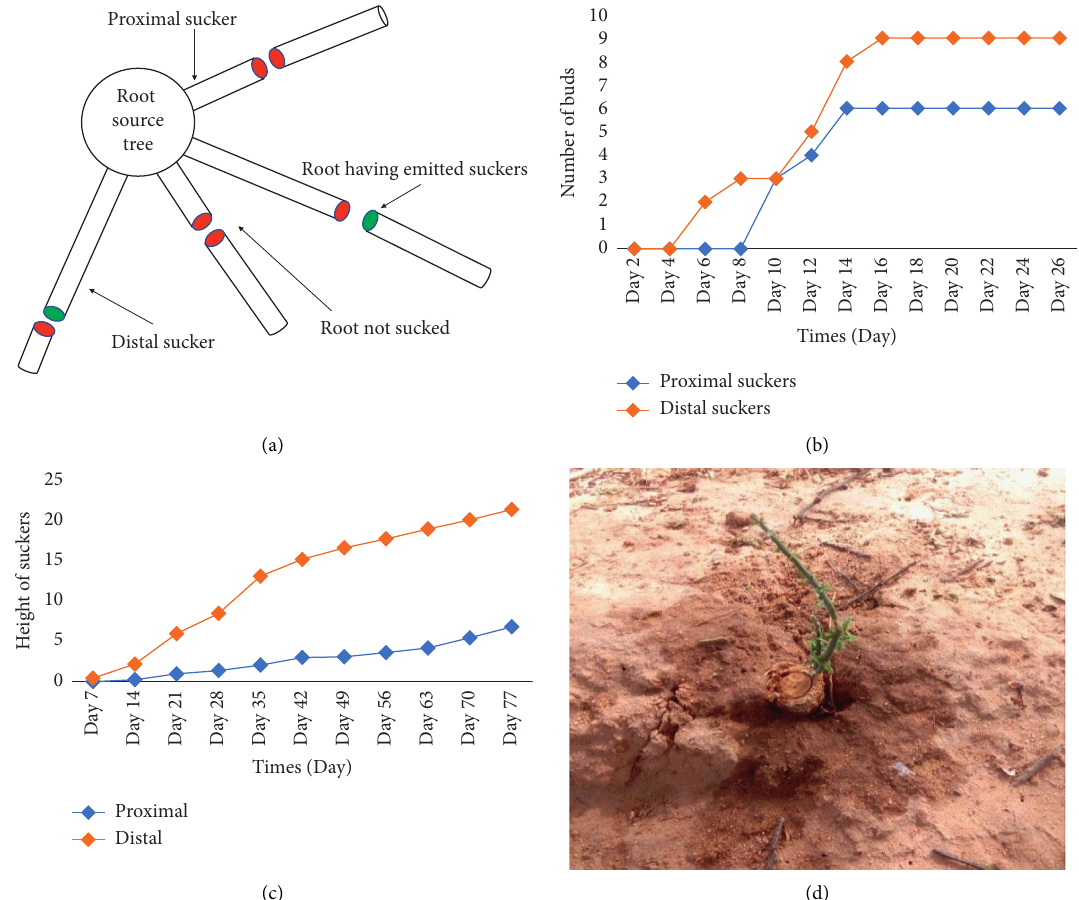
Figure 4: Parameters for monitoring suckers of Balanites aegyptiaca at the Regional Centre for Agricultural Research (CERRA), Maradi, Niger. Illustration of suckers (a), growth of the number of buds (b), growth of the height of suckers (c), and photo of suckers (d).